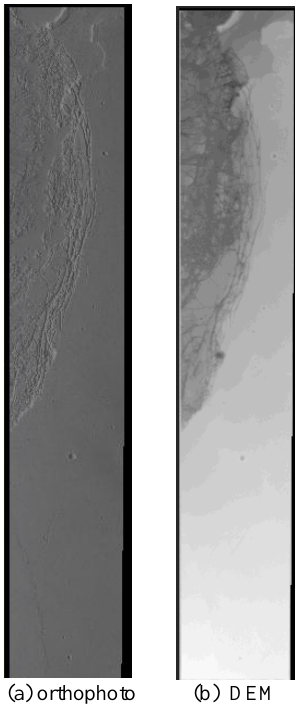
Figure 12. Mars Express orbit 5124 sampled with